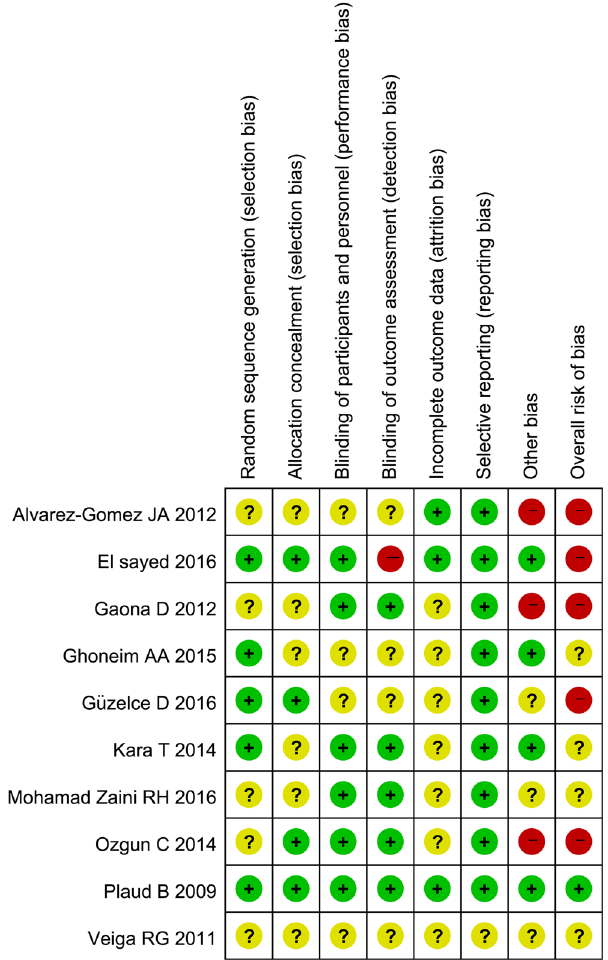
Figure 2. Summary of the risk of bias of the included